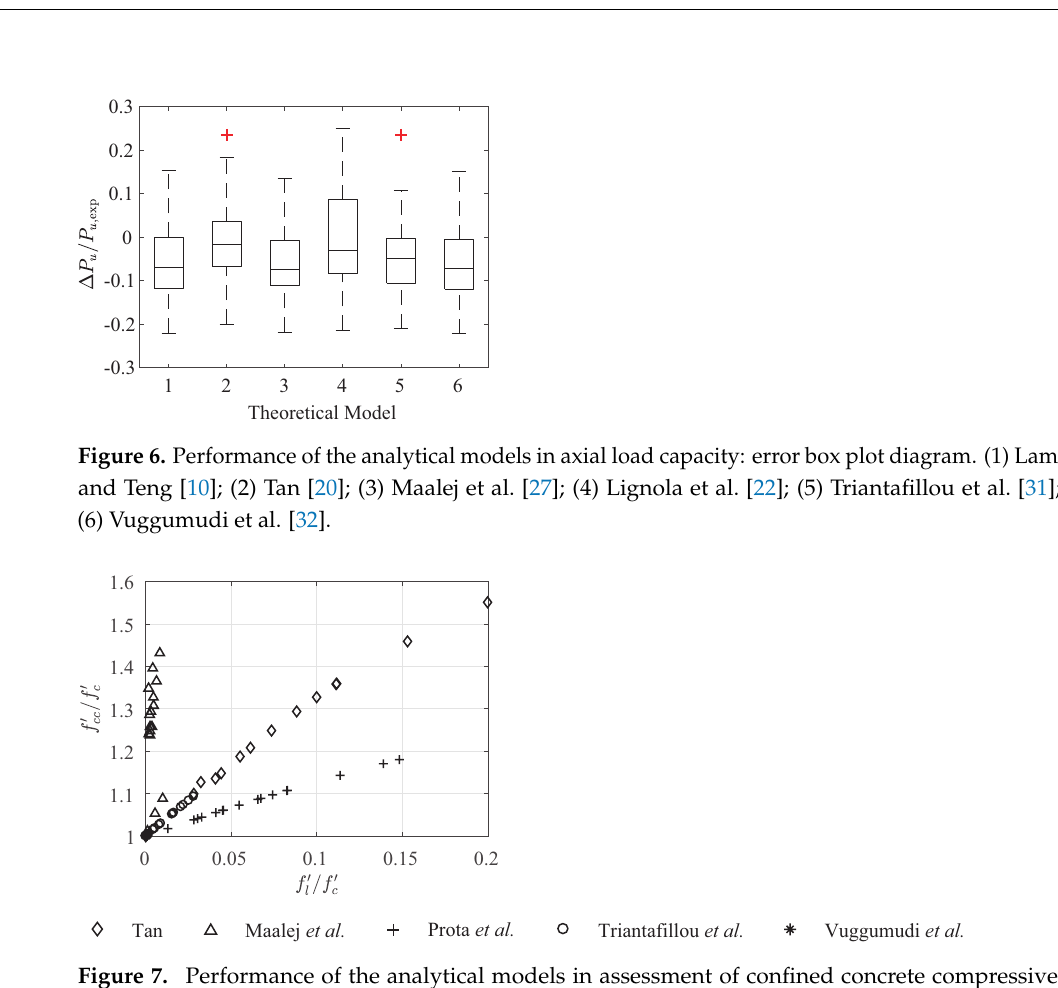
Figure 7. Performance of the analytical models in assessment of confined concrete compressive strength vs. confinement